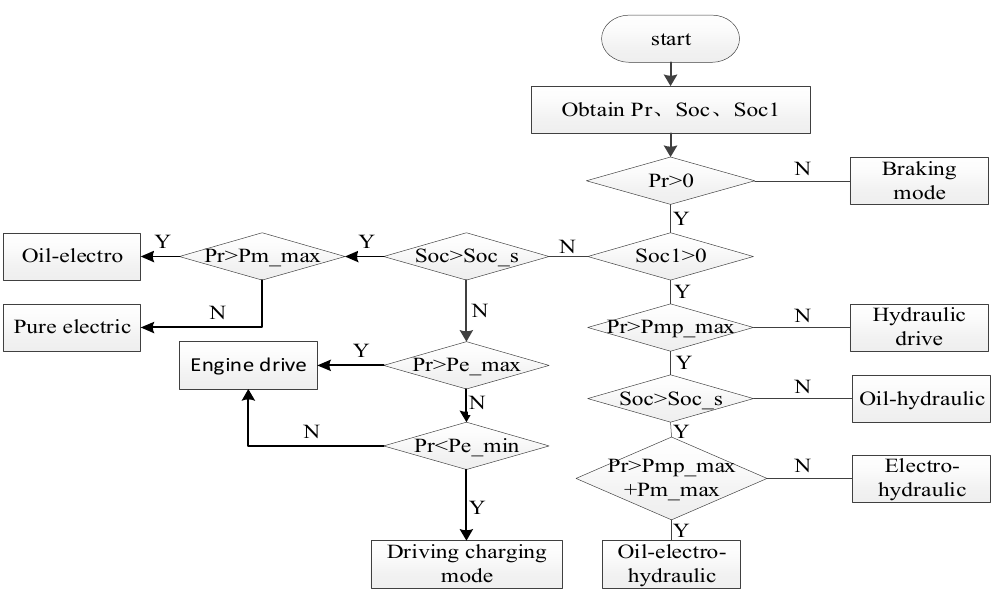
Figure 2. Mode selection logic diagram.